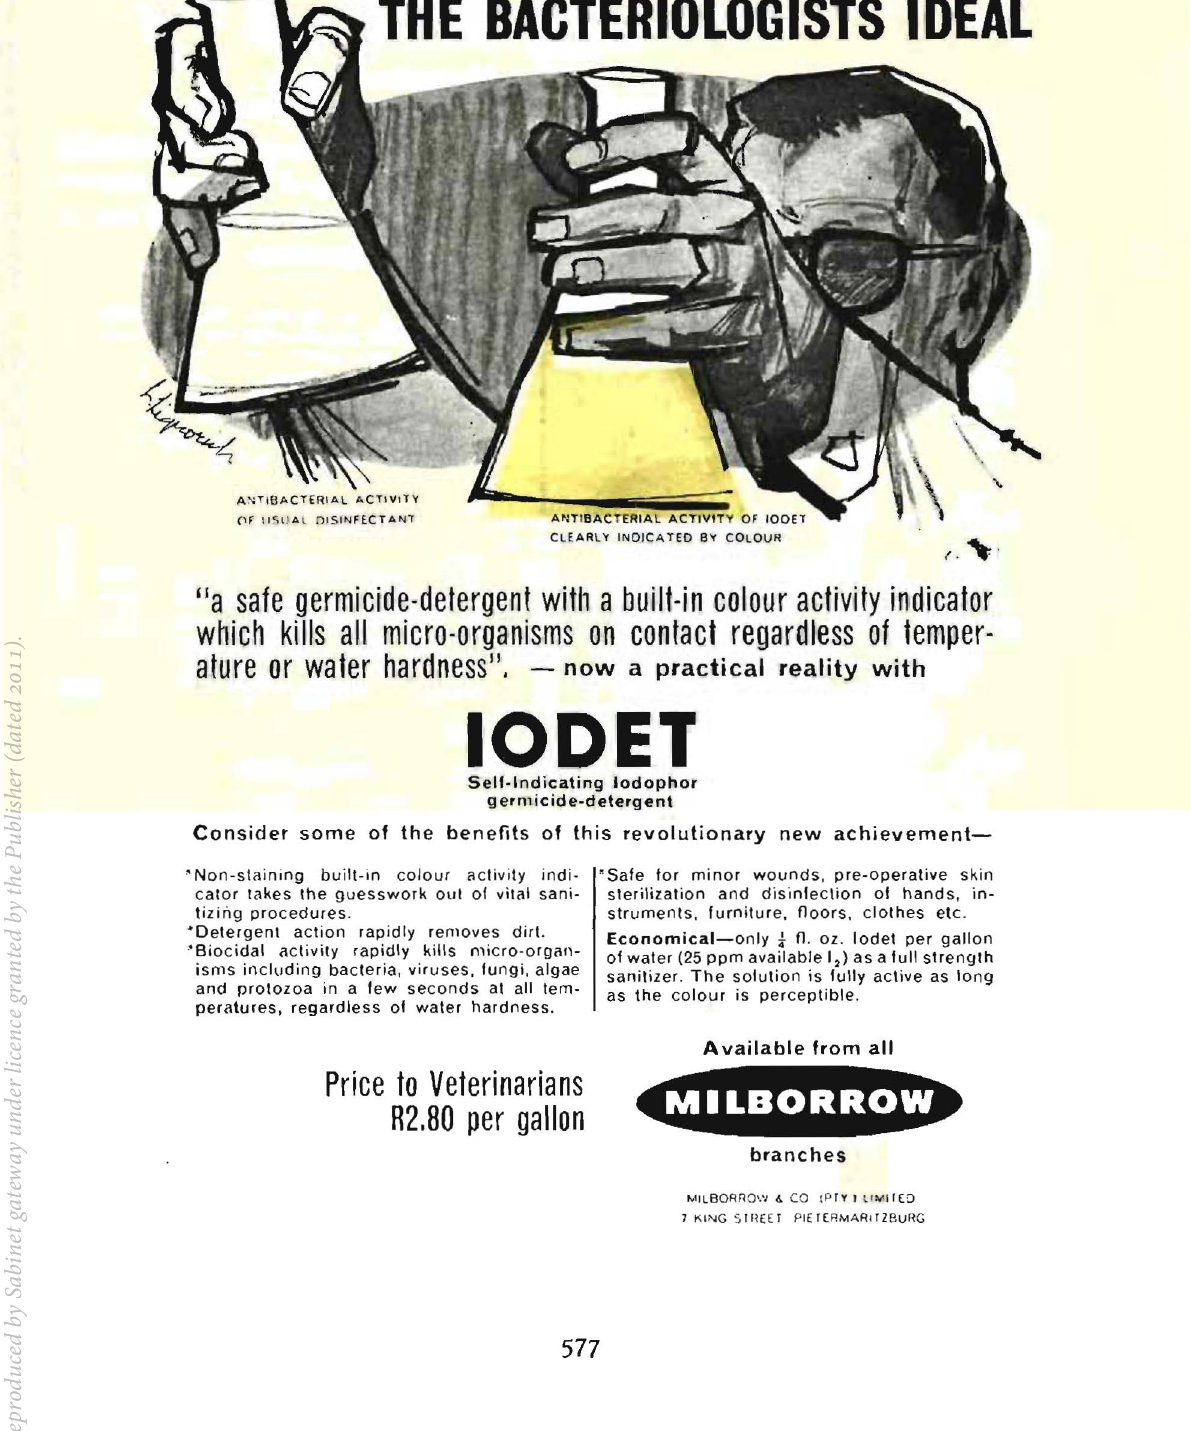
AI'-:TIBACTERIAl ACnvtTV or loon CLEARLY INDICATED BY COLOUR